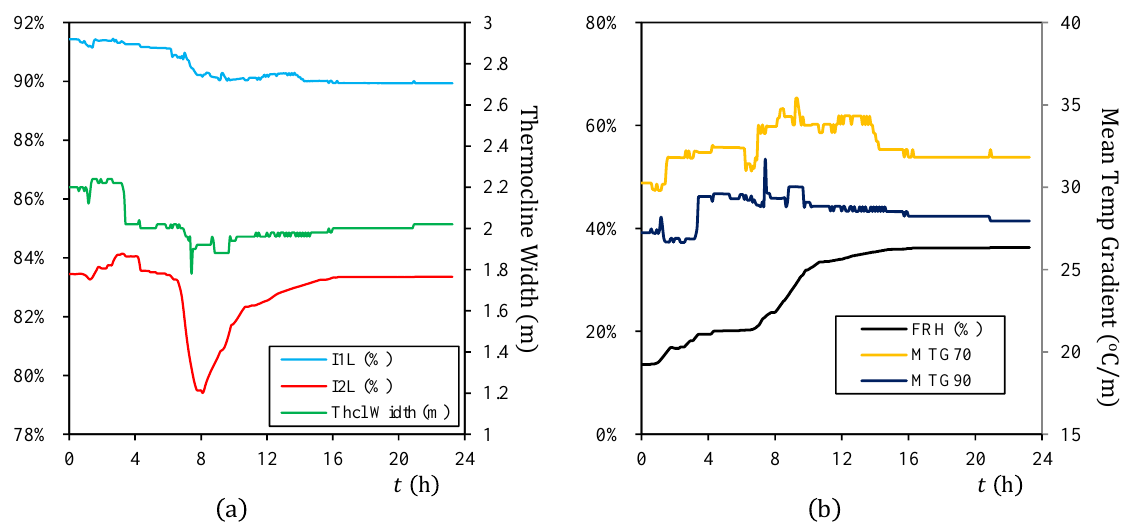
Figure 9. Results of: ( a ) I 1 L , I 2 L and thermocline width; ( b ) FRH , and Mean Temperature Gradients, for the double temperature step formation period in Figure